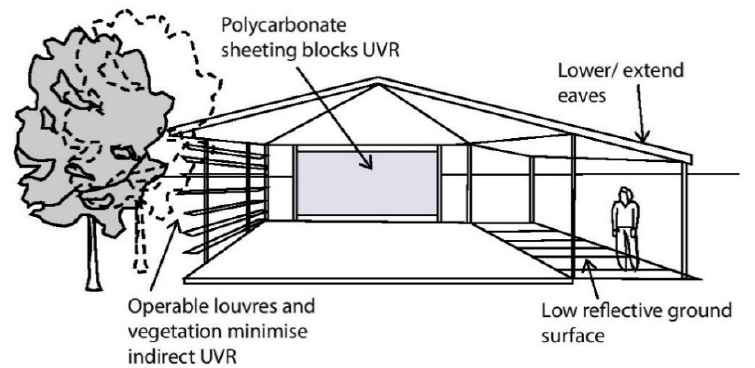
Figure 7. Strategies to minimize indirect UVR.